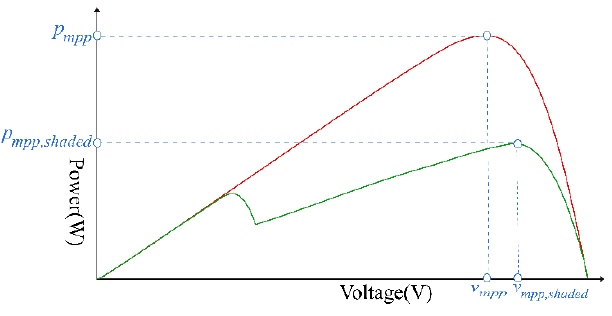
Figure 7. The P-V curve with two peak points under PSC.